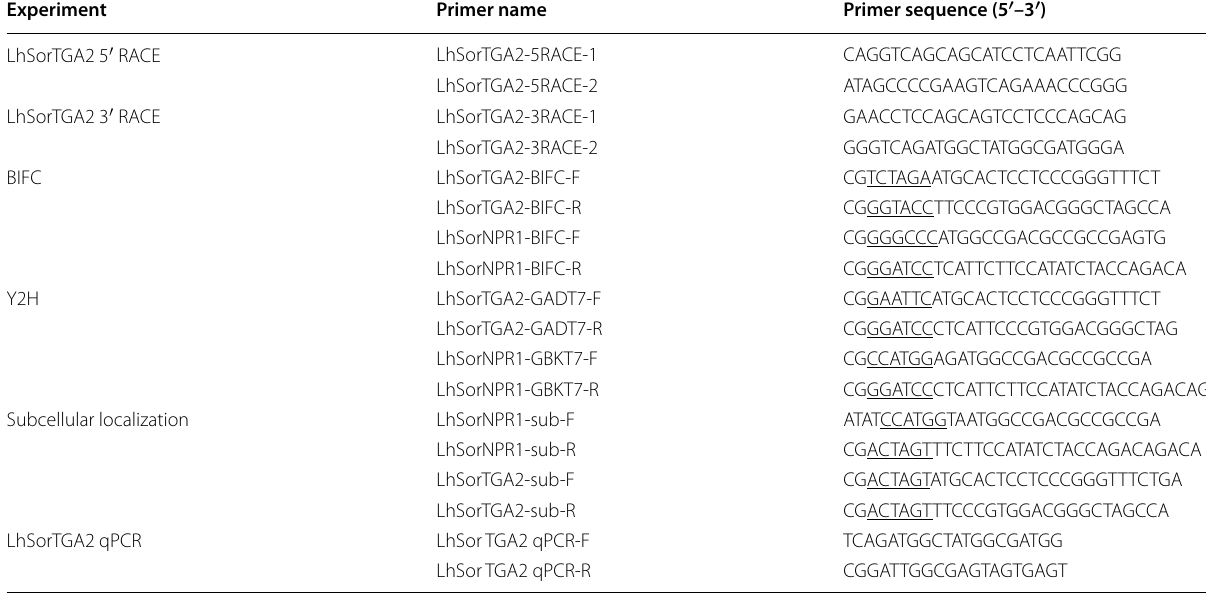
Restriction sites for vector construction are